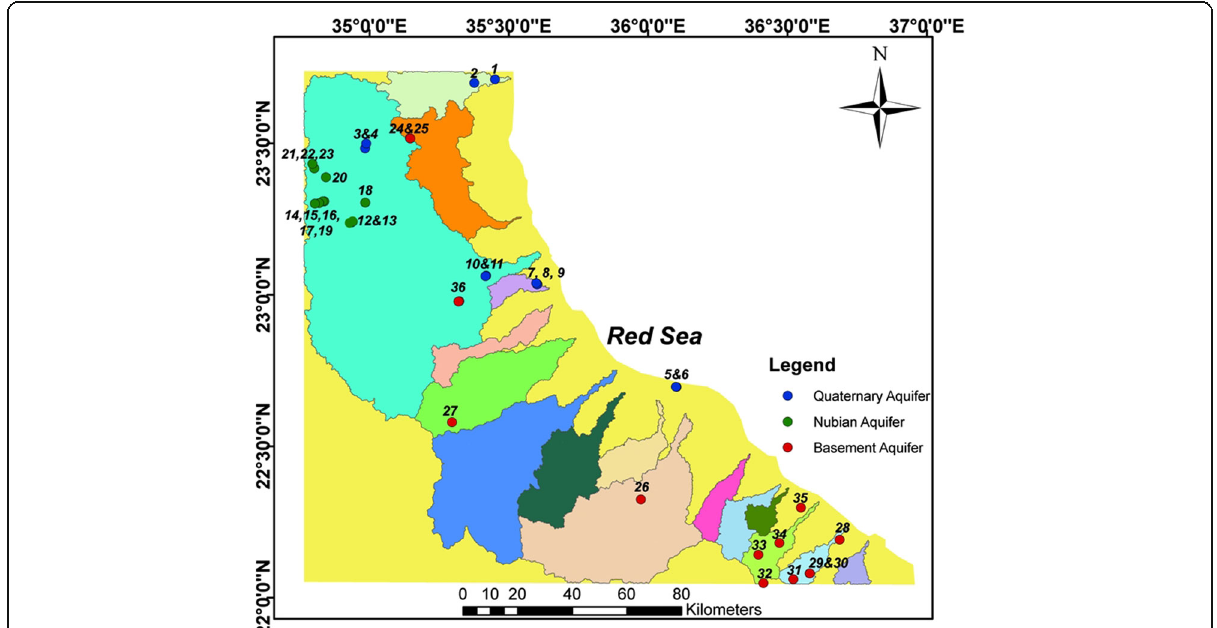
Fig. 9 Hydrographic basin of the study area extracted from DEM analyses